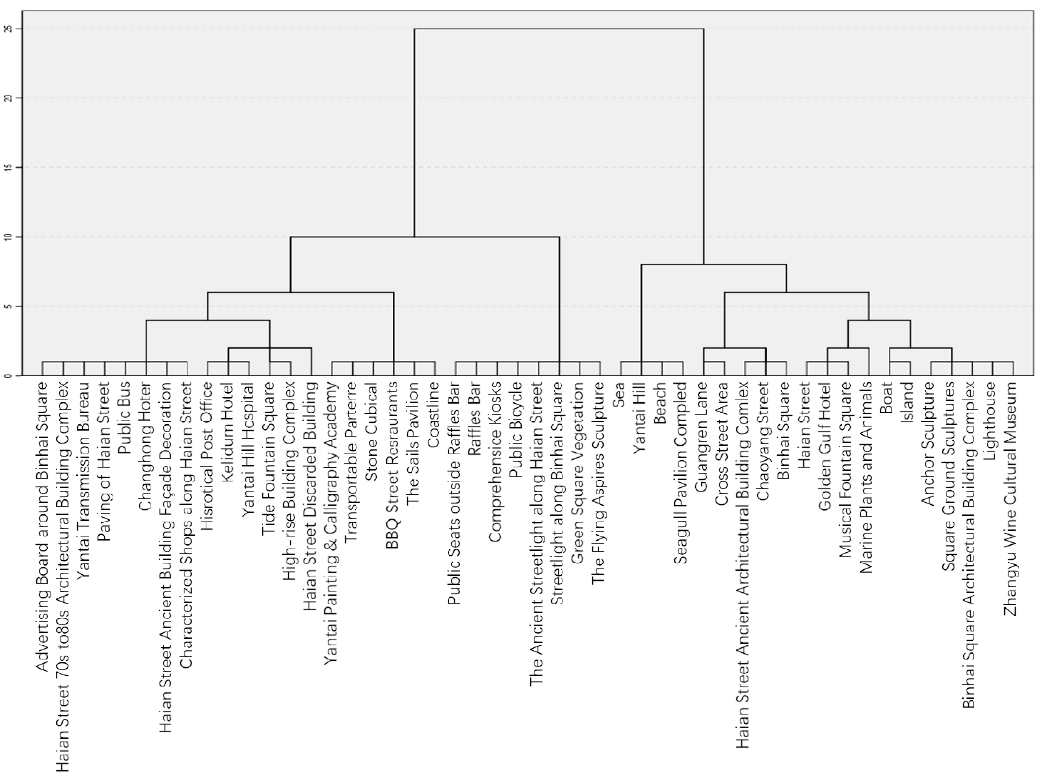
Figure 5. Hierarchical Cluster Analysis.